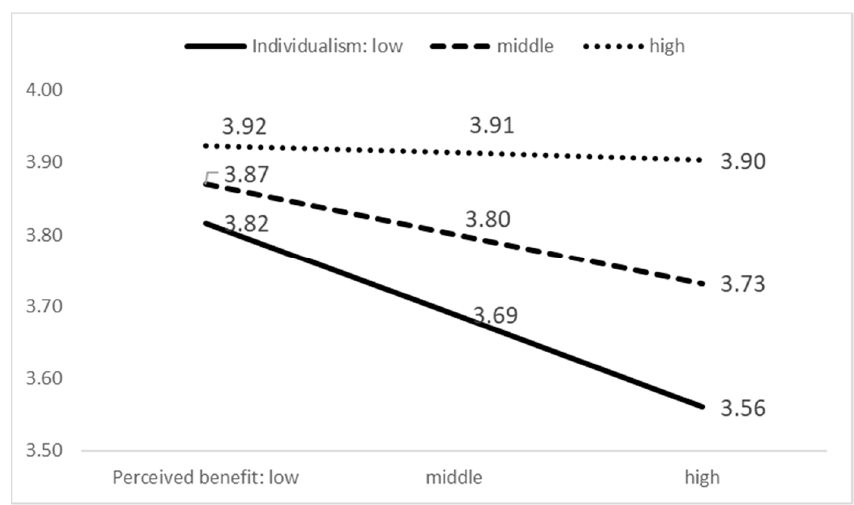
Figure 5. Perceived risk (IV) × individualism (M) = skepticism (DV).